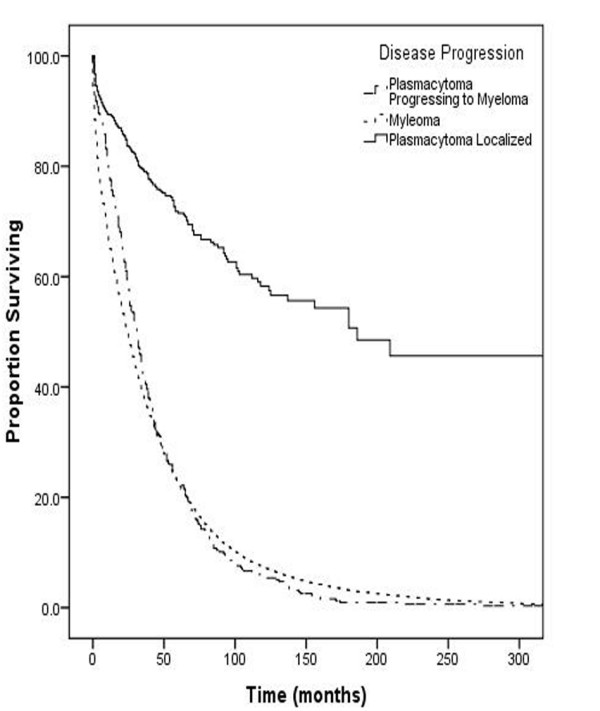
Overall Survival stratified by Disease Progression.